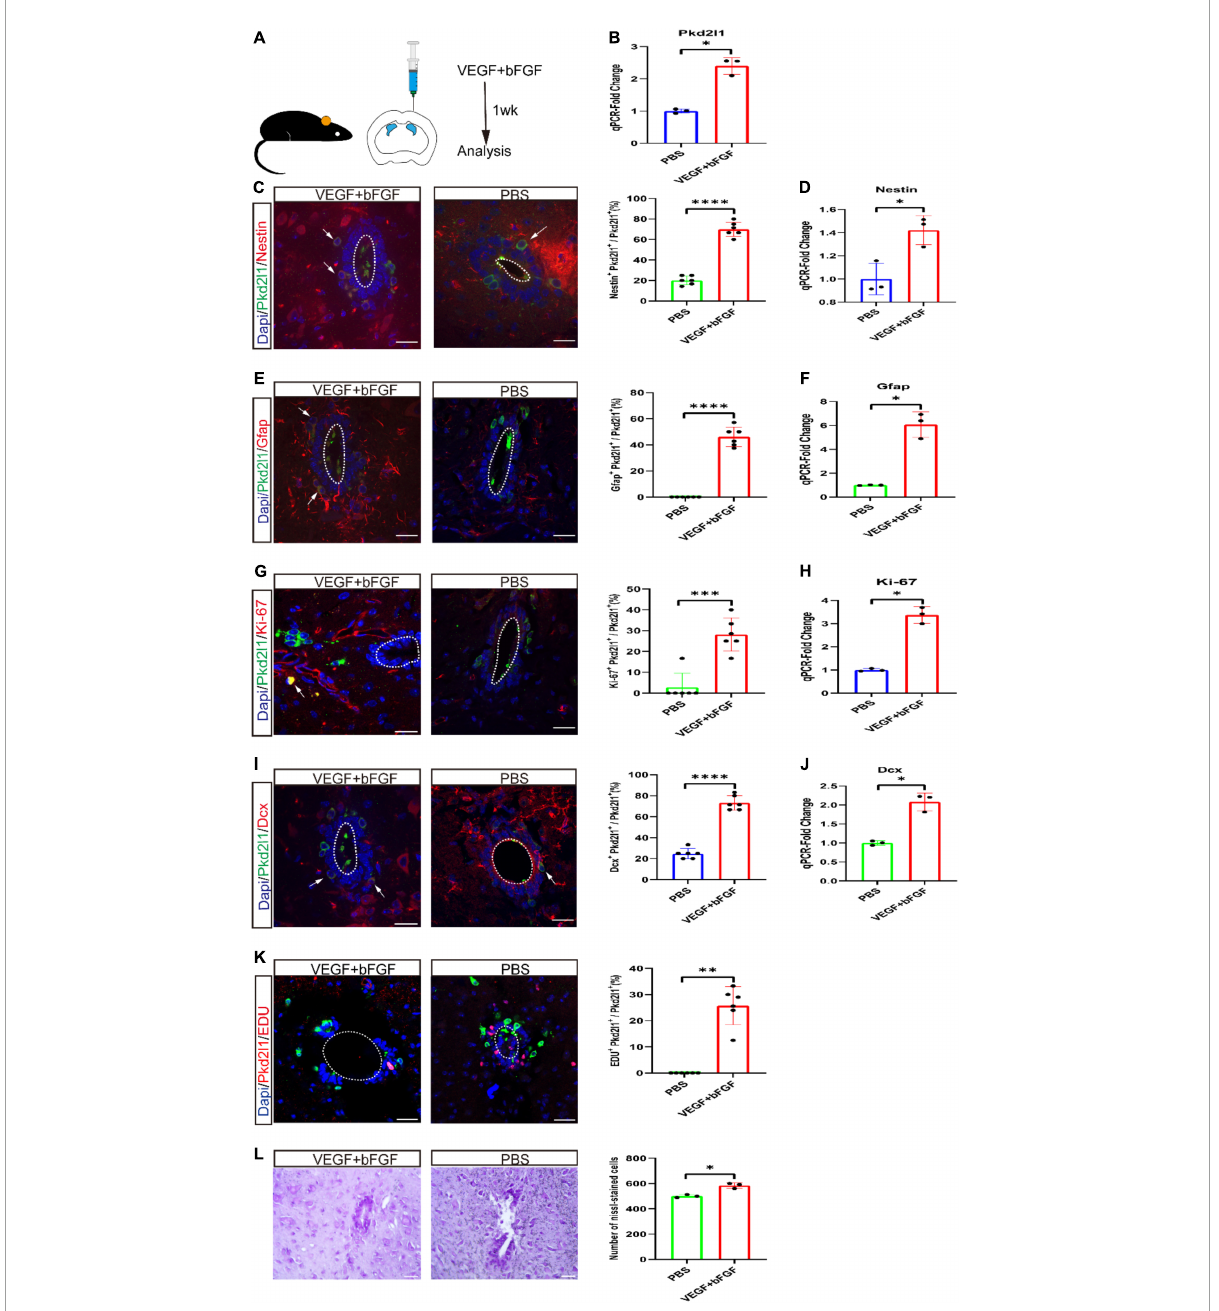
FIGURE4 Cerebrospinal fluid-contacting neurons (CSF-cNs) activating proliferative or neurogenic potential after ventricular vascular endothelial growth factor (VEGF) and basic fibroblast growth factor (bFGF) injection. (A) VEGF and bFGF or PBS were injected into the right lateral ventricle by stereotaxic apparatus. (B) qRT-PCR demonstrated an obvious increase in PKD2L1 expression following infusion of VEGF and bFGF compared to PBS ( ∗ p < 0.05, n = 3). (C,D) Representative images displayed a robust increase in Nestin- (red) and Pkd2l1 (green) marked cells in the central canal following infusion of VEGF and bFGF compared to PBS. qRT-PCR demonstrated an apparent increase in Nestin expression following infusion of VEGF and bFGF compared to PBS. (E,F) Pkd2l1 (green) positive cells in the central canal expressed GFAP (red) following infusion of VEGF and bFGF compared to PBS. qRT-PCR demonstrated an obvious rise in Gfap expression following infusion of VEGF and bFGF compared to PBS. (G,H) The proportion of Ki-67 (red) and Pkd2l1 (green) marked cells in the central canal significantly increased following infusion of VEGF and bFGF compared to PBS. qRT-PCR demonstrated a significant increase in Ki-67 expression following infusion of VEGF and bFGF compared to PBS. (I,J) Representative images displayed a significant increase in Dcx (red) and Pkd2l1 (green) marked cells in the central canal following infusion of VEGF and bFGF compared to PBS. qRT-PCR demonstrated an obvious increase in Dcx expression following infusion of VEGF and bFGF compared to PBS. (K) Representative images demonstrated that Pkd2l1 + cells (green) incorporated EdU (red) at 1 week following infusion of VEGF and bFGF compared to PBS. (L) Representative images indicated a significant increase in Nissl-positive cells at 1 week following infusion of VEGF and bFGF compared to PBS. White arrows: double-labeled cells. ∗ p < 0.05, ∗∗ p < 0.01, ∗∗∗ p < 0.001, ∗∗∗∗ p < 0.0001. The scale bar represents 20 µ m (C,E,G,I,K,L)